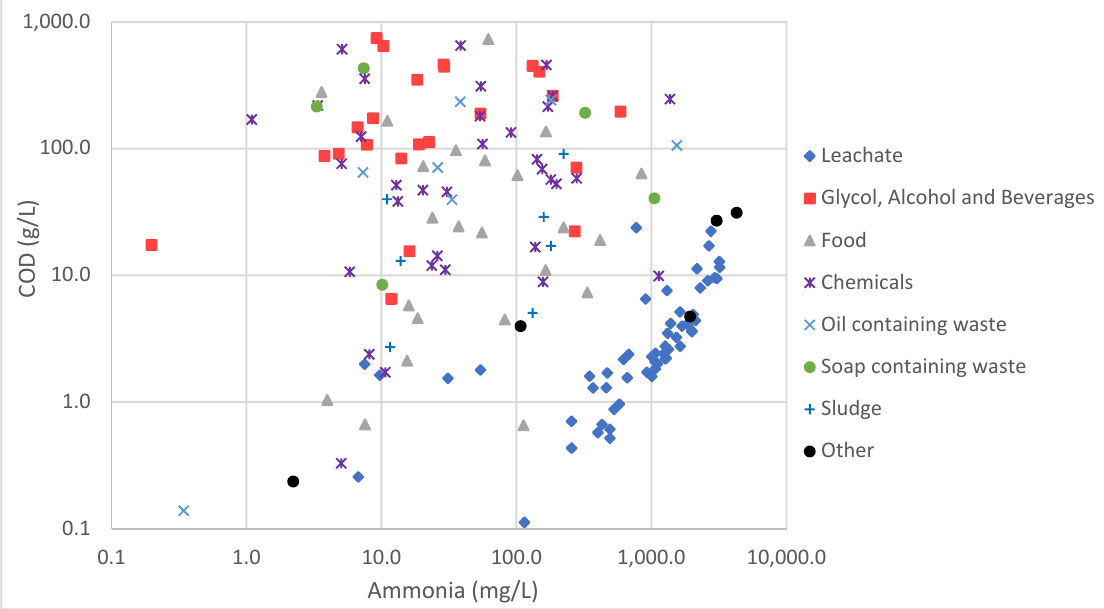
Figure 2. COD versus ammonia concentrations of TWs grouped by their source.